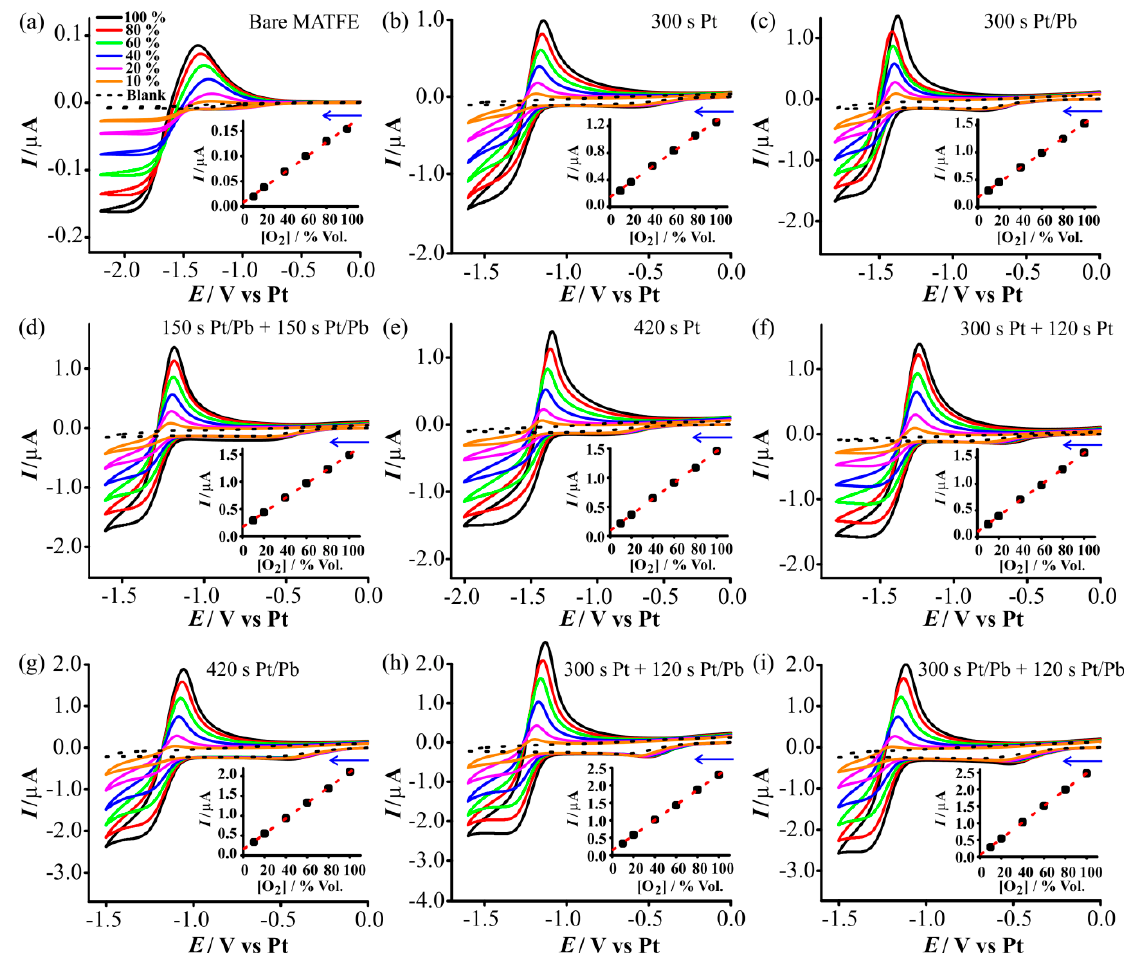
Figure 4. Cyclic voltammetry (CV) at 100 mVs − 1 for the reduction of oxygen (10–100% vol.) in [N 8,2,2,2 ][NTf 2 ] on the different prepared MATFEs: ( a ) recessed, ( b ) 300 s Pt, ( c ) 300 s Pt/Pb, ( d ) 150 s Pt/Pb + 150 s Pt/Pb, ( e ) 420 s Pt, ( f ) 300 s Pt + 120 s Pt, ( g ) 420 s Pt/Pb, ( h ) 300 s Pt + 120 s Pt/Pb, ( i ) 300 s Pt/Pb + 120 s Pt/Pb. The dashed line is the response in the absence of oxygen. Currents on all surfaces were measured from a suitable potential, where the voltammetry showed steady state currents. The insets show the calibration plots of peak current (baseline corrected) vs. concentration, along with the line of best fit.